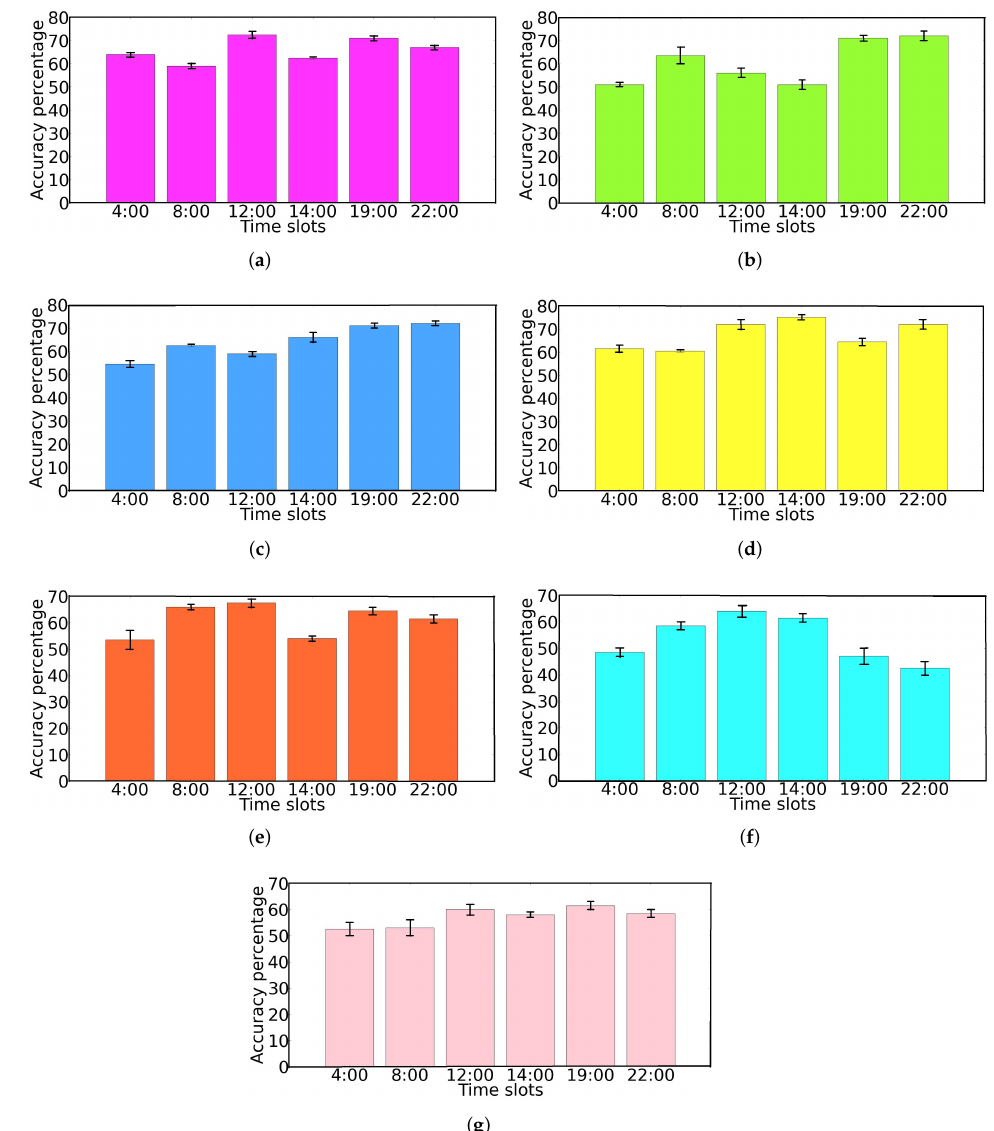
Figure 8. Trajectory density prediction accuracy of different days and time slots. ( a ) Monday;